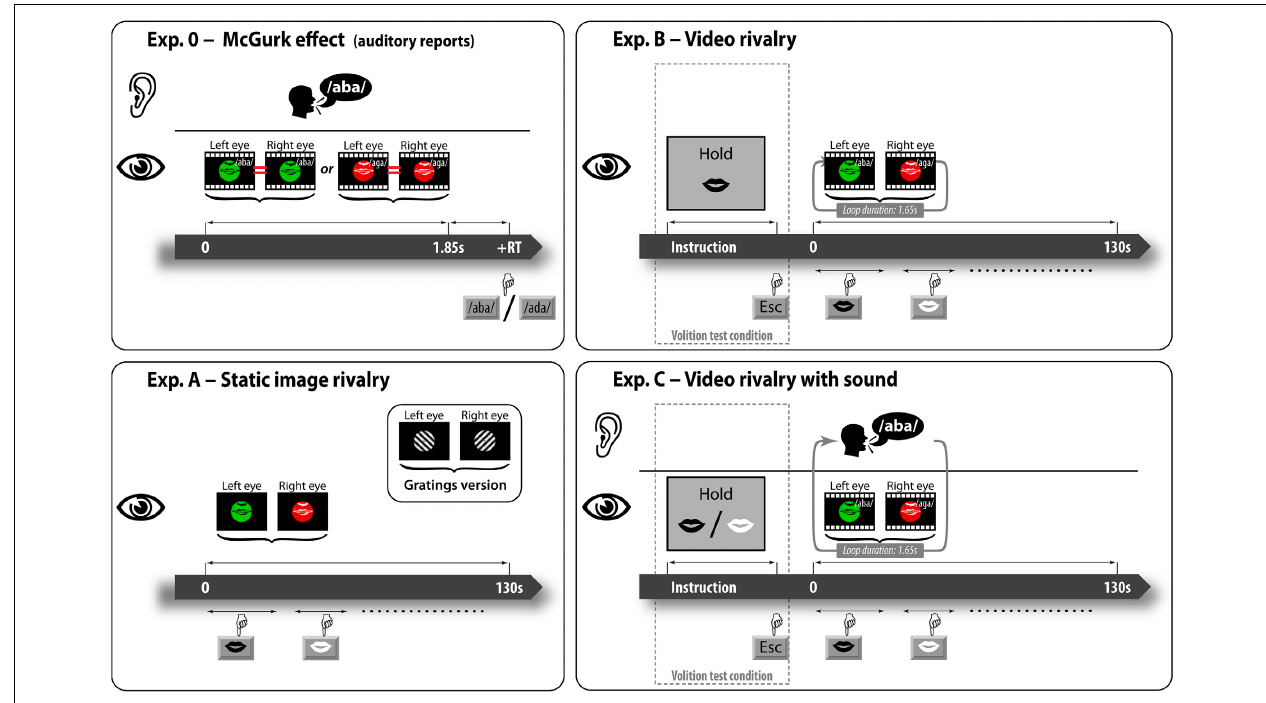
FIGURE 2 | Trial timelines of the experiments. In the preliminary experiment, subjects viewed single sequences of videos (no rivalry here) synchronized with the /aba/ voice and then selected the auditory percept (either /aba/ or /ada/). In the main experiments, subjects reported continuously during 130s trials the currently seen percept (lips